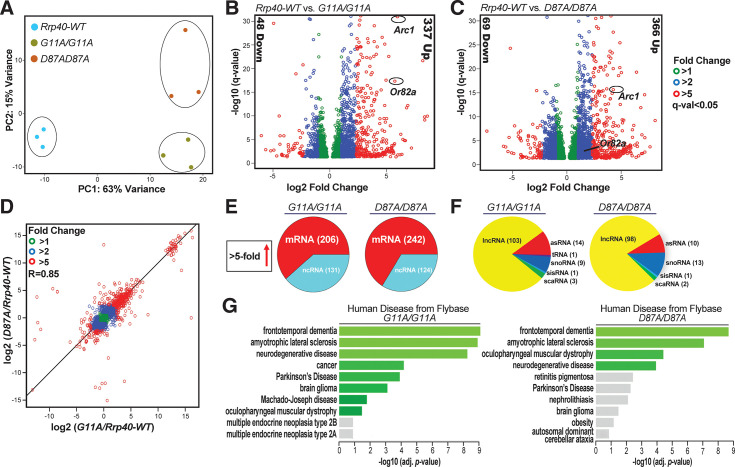
RNA-seq analysis of Rrp40 mutant flies identifies key neuronal targets that are altered.(A) Principal component analysis (PCA) analysis of RNA-seq data from adult Drosophila heads from Rrp40-WT and Rrp40 mutant flies (Rrp40G11A and Rrp40D87A) shows that results from the three independent experiments cluster based on the genotype and that mutants are more distinct from control flies than from one another. (B,C) Volcano plots show transcripts differentially expressed in each Rrp40 mutant [(B) G11A/G11A (2,351) and (C) D87A/D87A (3,502)] compared to Rrp40-WT (q<0.05, DEseq). The number of transcripts that show ≥ 5-fold change in steady-state levels (Down or Up) are indicated to the side in each plot. Representative regulators of neuronal function in flies (Arc1 and Or82a) are highlighted. (D) A correlation curve comparing the changes in gene expression relative to wildtype for each Rrp40 allele (G11A/G11A and D87A/D87A) was produced by plotting on a logarithmic scale. This analysis shows that the changes in transcript levels are highly correlated (R = 0.85) with respect to both magnitude and direction. (E) A pie chart illustrates the class of RNAs affected in each Rrp40 mutant by showing total RNAs increased at least 5-fold in each Rrp40 mutant corresponding to coding (mRNA) and non-coding RNA (ncRNA). (F) A pie chart illustrates the classes of ncRNAs increased at least 5-fold in each Rrp40 mutant (lncRNAs, long noncoding RNAs; asRNAs, Antisense RNAs; tRNAs, transfer RNAs; snoRNAs, small nucleolar RNAs; sisRNAs, stable intronic sequence RNAs; scaRNAs, small Cajal body RNAs). (G) The enriched pathways from FlyEnrichr database for Human Disease from Flybase are shown for transcripts that are increased at least 1.2-fold in each Rrp40 mutant (left, G11A/G11A; right, D87A/D87A) as compared to Rrp40-WT. The bars shown in green correspond to significant enrichment (Adj. p-val<0.05).